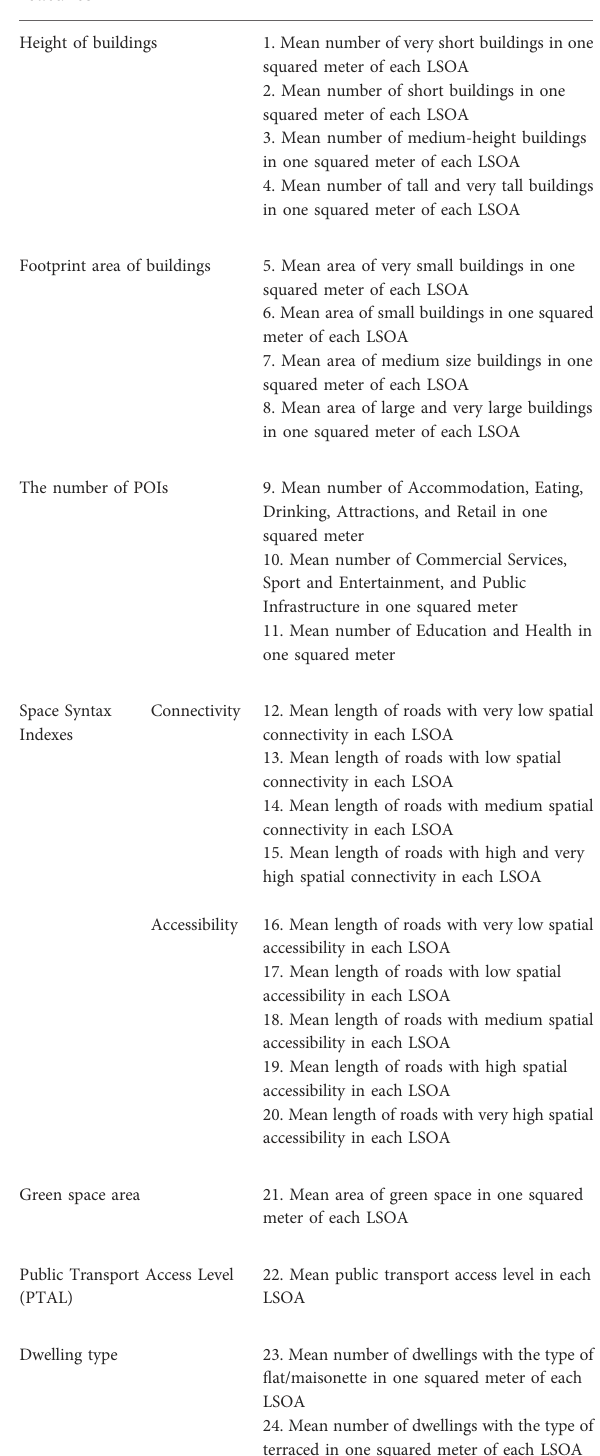
TABLE 2 Classi fi cation of urban